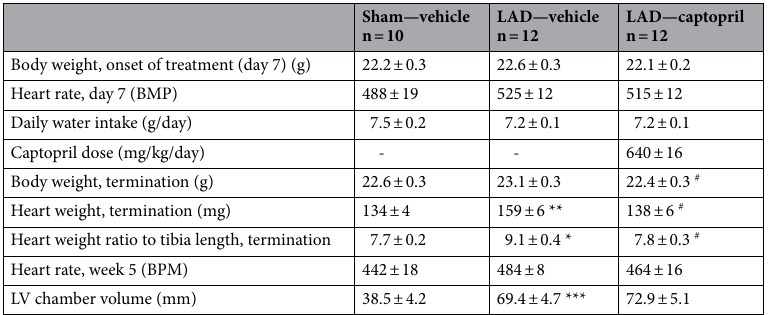
Table 1. Baseline and terminal characteristics of study groups. Body weight and echocardiography derived heart rate measured at the onset of treatment (day 7) and/or termination. Heart weight was measured after tissue clearing for light sheet imaging. End-diastolic LV chamber volume was estimated on parasternal long axis view at the time of termination. Data is mean ± s.e.m. One-way ANOVA with Tukey’s post hoc